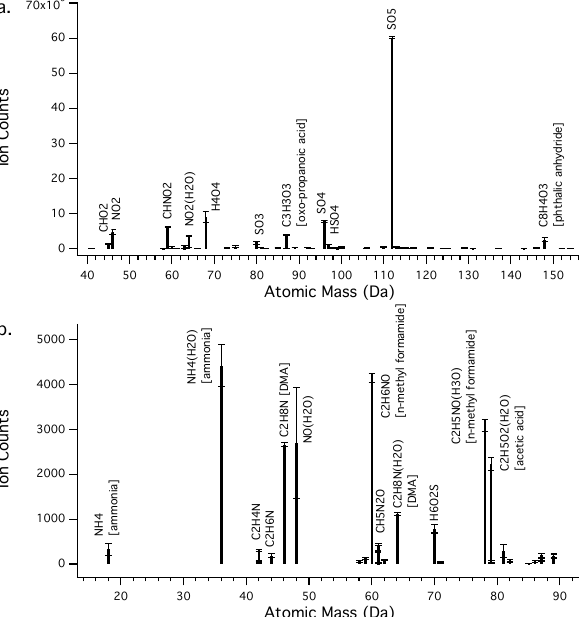
Figure 7. Negative (a) and positive (b) background-corrected 30min collection particle mass spectra for a particle forma- tion experiment with nominal 40ppt DMA, 23.5ppb O 3 , and 2.8 × 10 6 cm − 3 cm − 3 H 2 SO 4 , run 1033 on 16–17 October 2012. All species plotted have one elemental charge. The volume median diameter of collected particles was 10.9nm for positive ions and ) ion signals plotted against sul- Figure 6. Base (DMAH + + NH + 4 13.1nm for the negative ions. Particulate ammonium and dimethy- fate ion signals for ammonium sulfate and dimethylaminium bisul- laminium levels were similar, despite not adding gas-phase ammo- fate calibration aerosol overestimated sample loadings of 0 to nia intentionally to the chamber. N -methyl formamide was a con- 1.8ng, conducted in the laboratory at NCAR after CLOUD7 (the taminant generated in the particle chargers. The negative spectrum same tests as presented in Fig. 5). Signals were scaled by collected is dominated by the sulfate-derived peak SO − . The instrument is 5 mass to match positive and negative analyses. Despite the nonlinear ) than to am- more sensitive to ammonium nitrate (detected as NO − character in the individual ions’ dependence on the sample mass 2 monium sulfate by a factor of ∼ 100 (Bzdek et al., 2014), so the ni- (Fig. 5), the base:acid ratio remains constant over a range of col- trate contamination is likely a small fraction of the sampled aerosol lected masses for the same calibration aerosol, in agreement with mass. the ammonium sulfate aerosol calibration performed at CLOUD7 (Fig. 5). Note that relative sensitivities to base and acid were differ- ent during this test than during the calibrations at CLOUD7 (Fig. 5), HSO − . The oxidized sulfur signal per estimated which should be considered the better comparison for the exper- 4 imental particle data since they were conducted under CLOUD7 conditions.